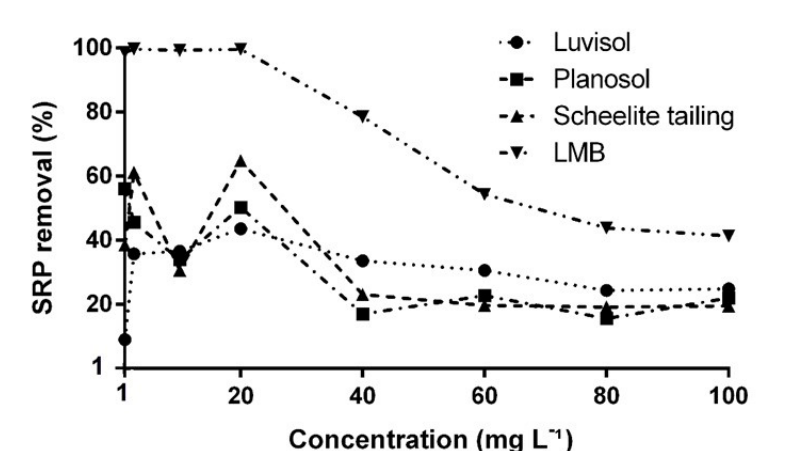
Figure 3. Soluble reactive phosphorus (SRP) removal capabilities of the natural and treated adsorbent materials. LMB=Lanthanum Modified Bentonite; SRP=Soluble Reactive